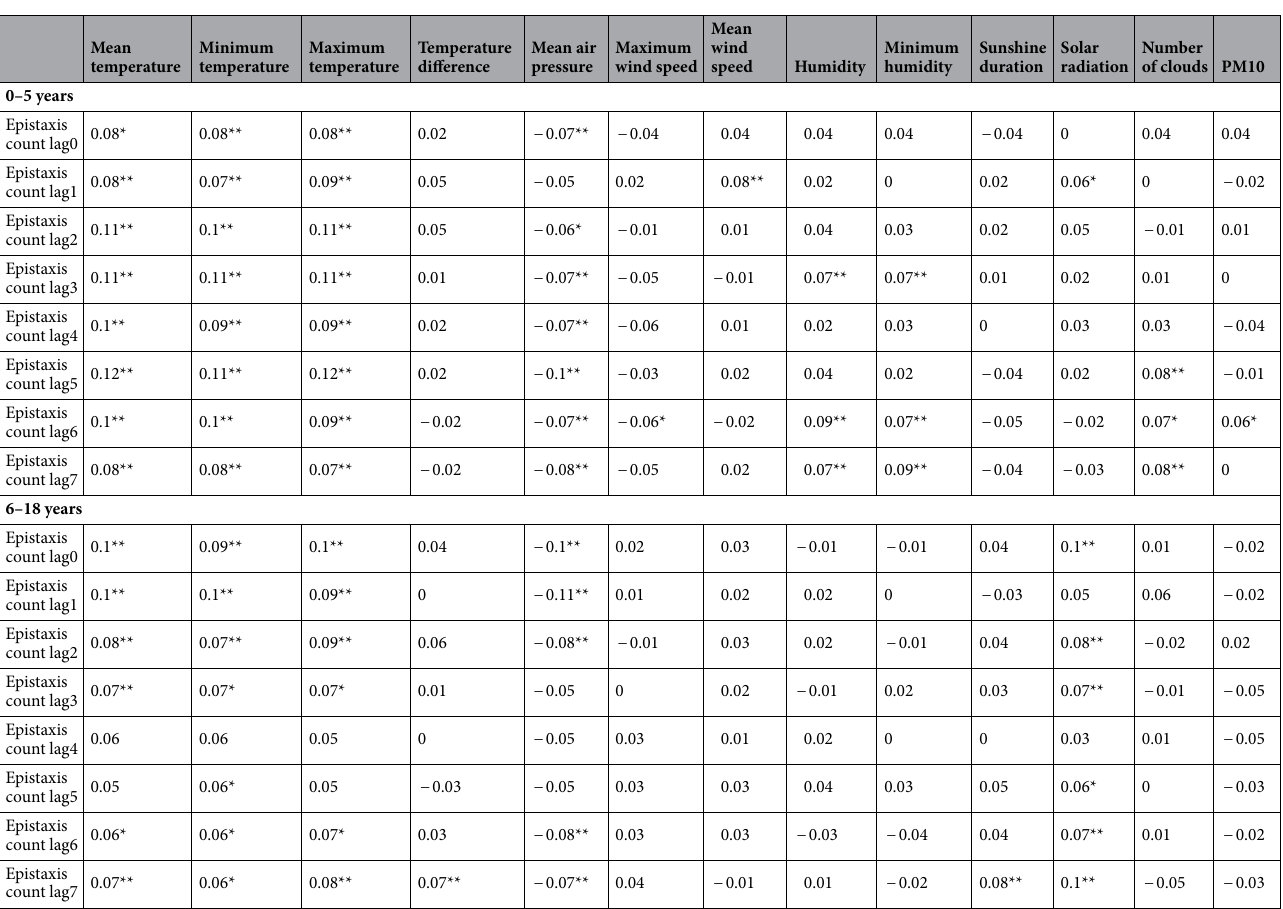
Table 4. Time-lag effect between the number of epistaxis presentations per day and other variables. * p value < 0.1, ** p value <